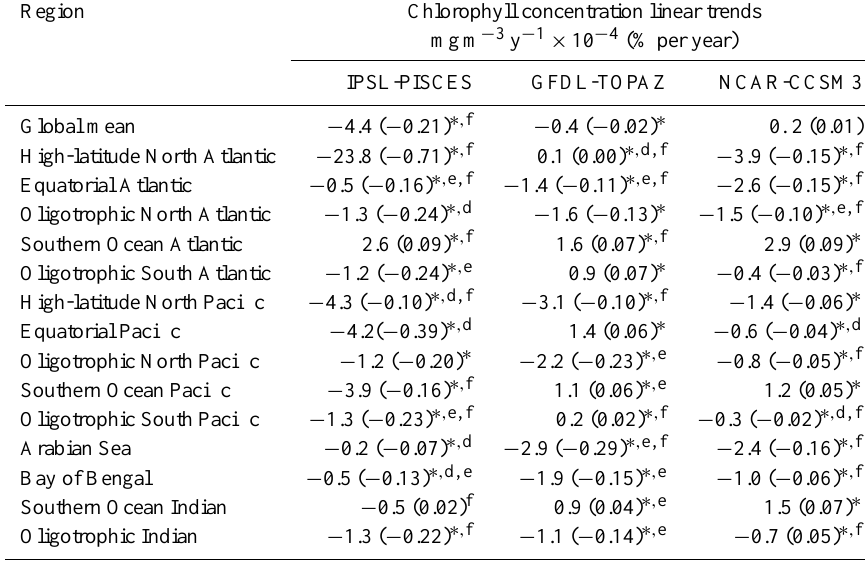
Table 2. Ocean chlorophyll generalized least square trends for 2001–2100 estimated from the model